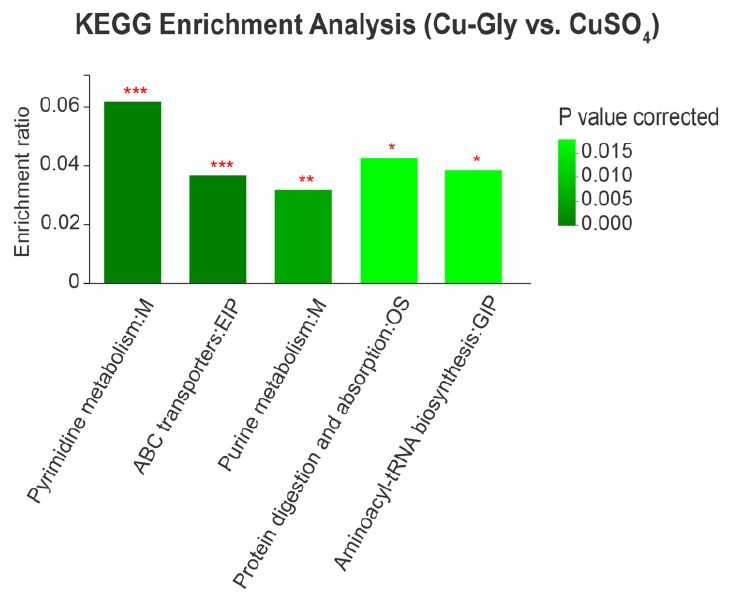
Figure 6. Differential metabolites were annotated, categorized, and enriched to the KEGG pathways. * represents a significant difference at p < 0.05, ** represents a significant difference at p < 0.01, *** represents a significant difference at p < 0.001. n = 6. KEGG, Kyoto Encyclopedia of Genes and Genomes. Table 3. Effects of Cu sources on the metabolite concentrations in the feces of pigs.